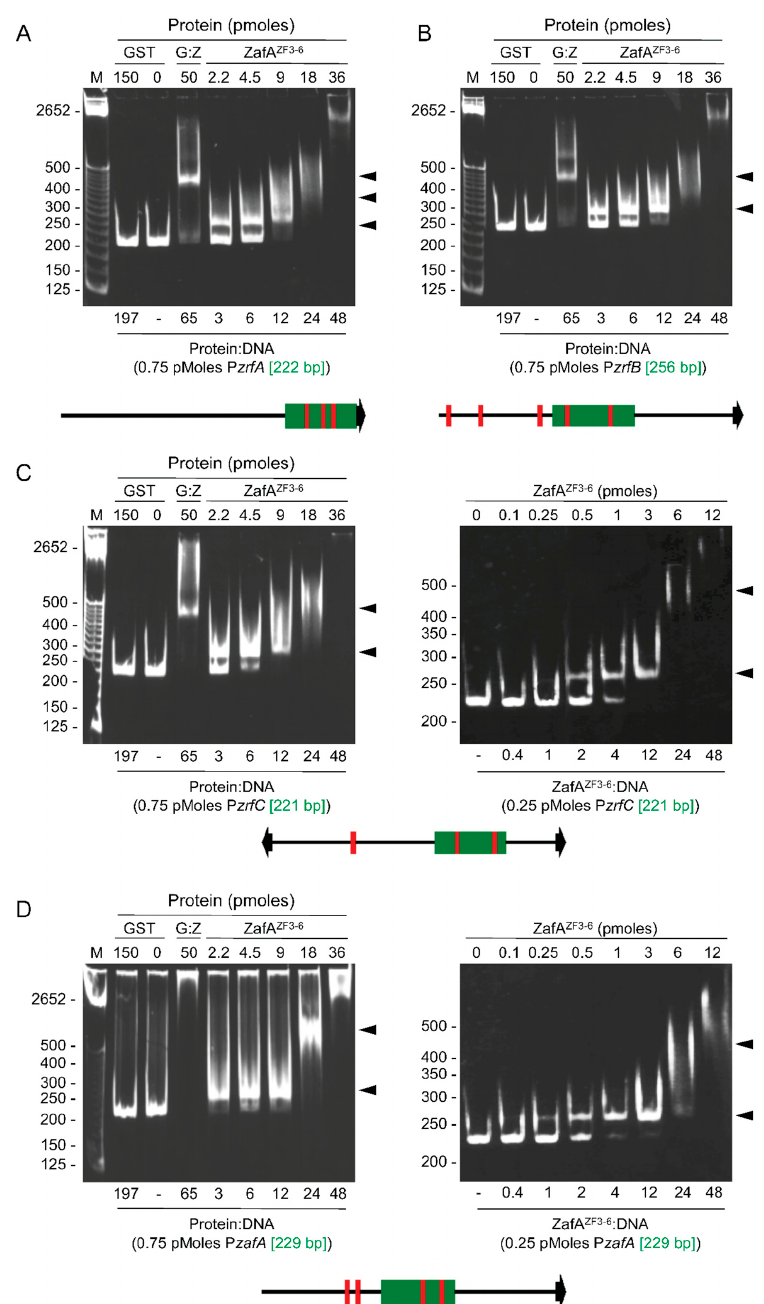
Figure 4. Analyses by Electrophoretic Mobility Shift Assays (EMSA) of the interaction of ZafA ZF3-6 with different DNA fragments. ( A ) Interaction of ZafA ZF3-6 with a DNA fragment from a promoter region of zrfA (green box) that carried three putative ZafA binding motifs (red boxes); ( B ) interaction of ZafA ZF3-6 with a DNA fragment from a promoter region of zrfB (green box) that carried two putative ZafA binding motifs (red boxes); ( C ) interaction of ZafA ZF3-6 with a DNA fragment from a promoter region of zrfC (green box) that carried two putative ZafA binding motifs (red boxes); ( D ) interaction of ZafA ZF3-6 with a DNA fragment from a promoter region of zafA (green box) that carried two putative ZafA binding motifs (red boxes). In the right panel of (C) and (D), reactions were analyzed with lower ZafA ZF3-6 :DNA ratios to gain resolution. All DNA fragments were also incubated without protein and in the presence of both 150 pmoles of purified GST and 50 pmoles of the fusion protein GST-ZafA ZF3-6 (as controls) to attain a GST:DNA ratio of 197 and a GST-ZafA ZF3-6 :DNA (G:Z) ratio 65. A 25-bp DNA ladder was used as a